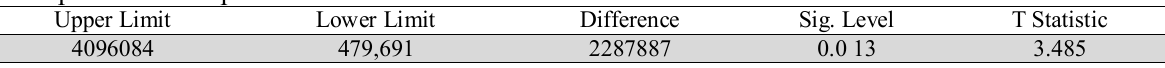
Comparison of the predicted firm values and market values Upper